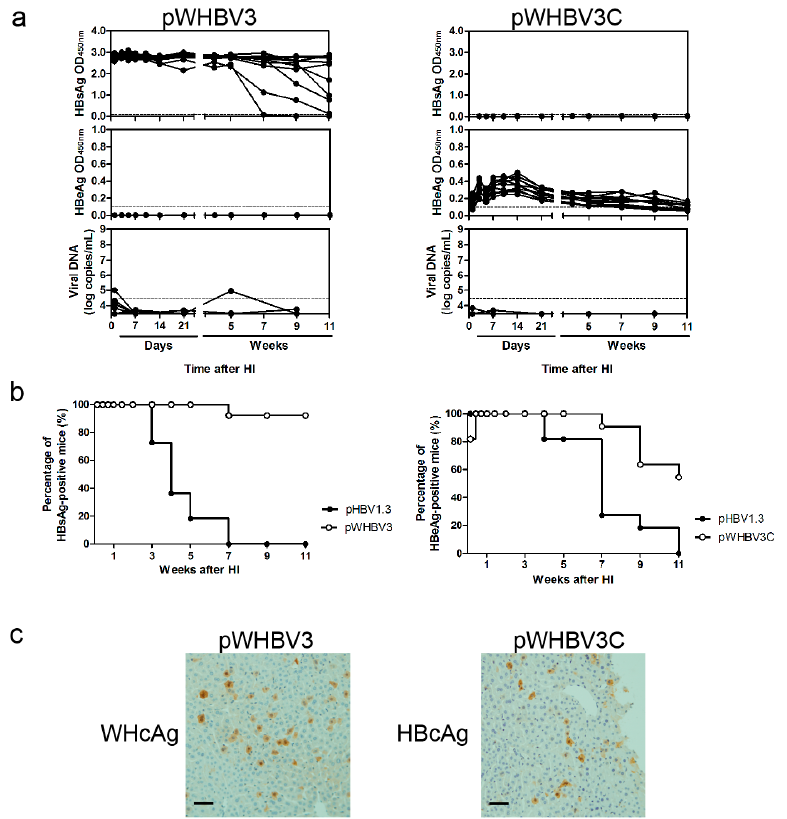
Figure 3. The kinetics of viral antigens and vDNA in sera, percentage of HBsAg and HBeAg antigenemia, and hepatic antigen expression after HI with pWHBV3 or pWHBV3C. ( a ) In mouse sera, viral antigens were measured via ELISA assay. The encapsidated vDNA was measured via qPCR. The cutoff values for ELISA and qPCR were set as 0.1 and 3 × 10 4 copies/mL, respectively, which were indicated by the dotted line; ( b ) The percentages of HBsAg antigenemia in pWHBV3-injected mice and the percentage of HBeAg antigenemia in pWHBV3C-injected mice were compared with pHBV1.3-challenged mice at the indicated time points; ( c ) At 10 dpi, HBcAg and WHcAg in mouse liver was measured via IHC. Magnification: 200×.